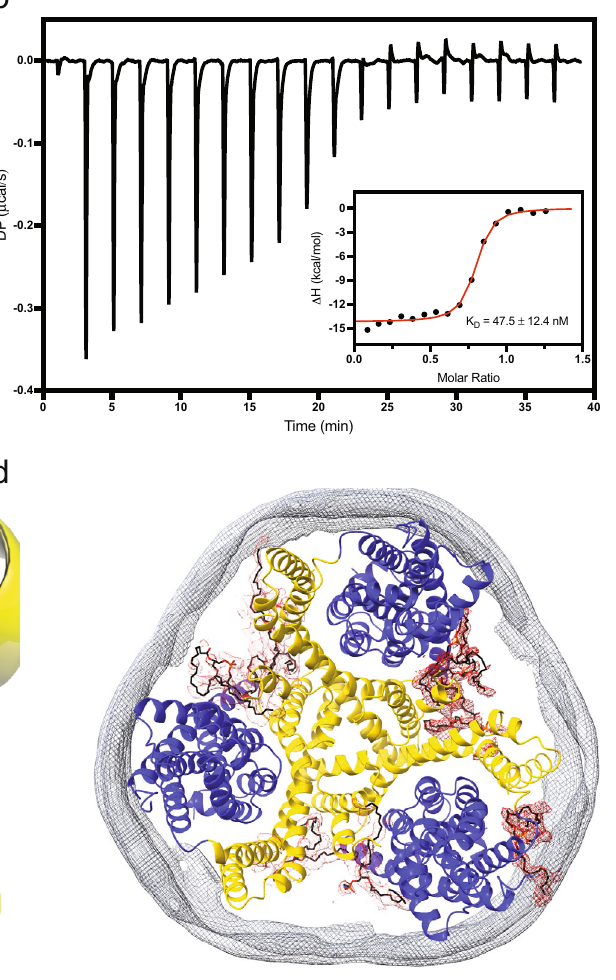
Fig. 4 | Structural integrity of the P208R mutant. The P208R mutation has no consequences to L-Asp binding as seen from ( a ) the comparison of binding sites betweenthemutantandWT(notethatnotonlyresiduesofthebindingsitebutalso the position of HP2 are similar) and ( b ) binding af fi nity measurements by ITC (the error is given by the standard deviation calculated on three independent